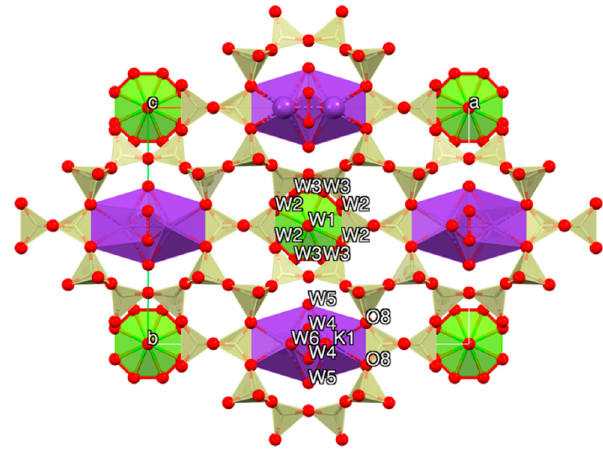
Figure 3. Sketch of the refined structure of the FER5 sample as seen along [001].